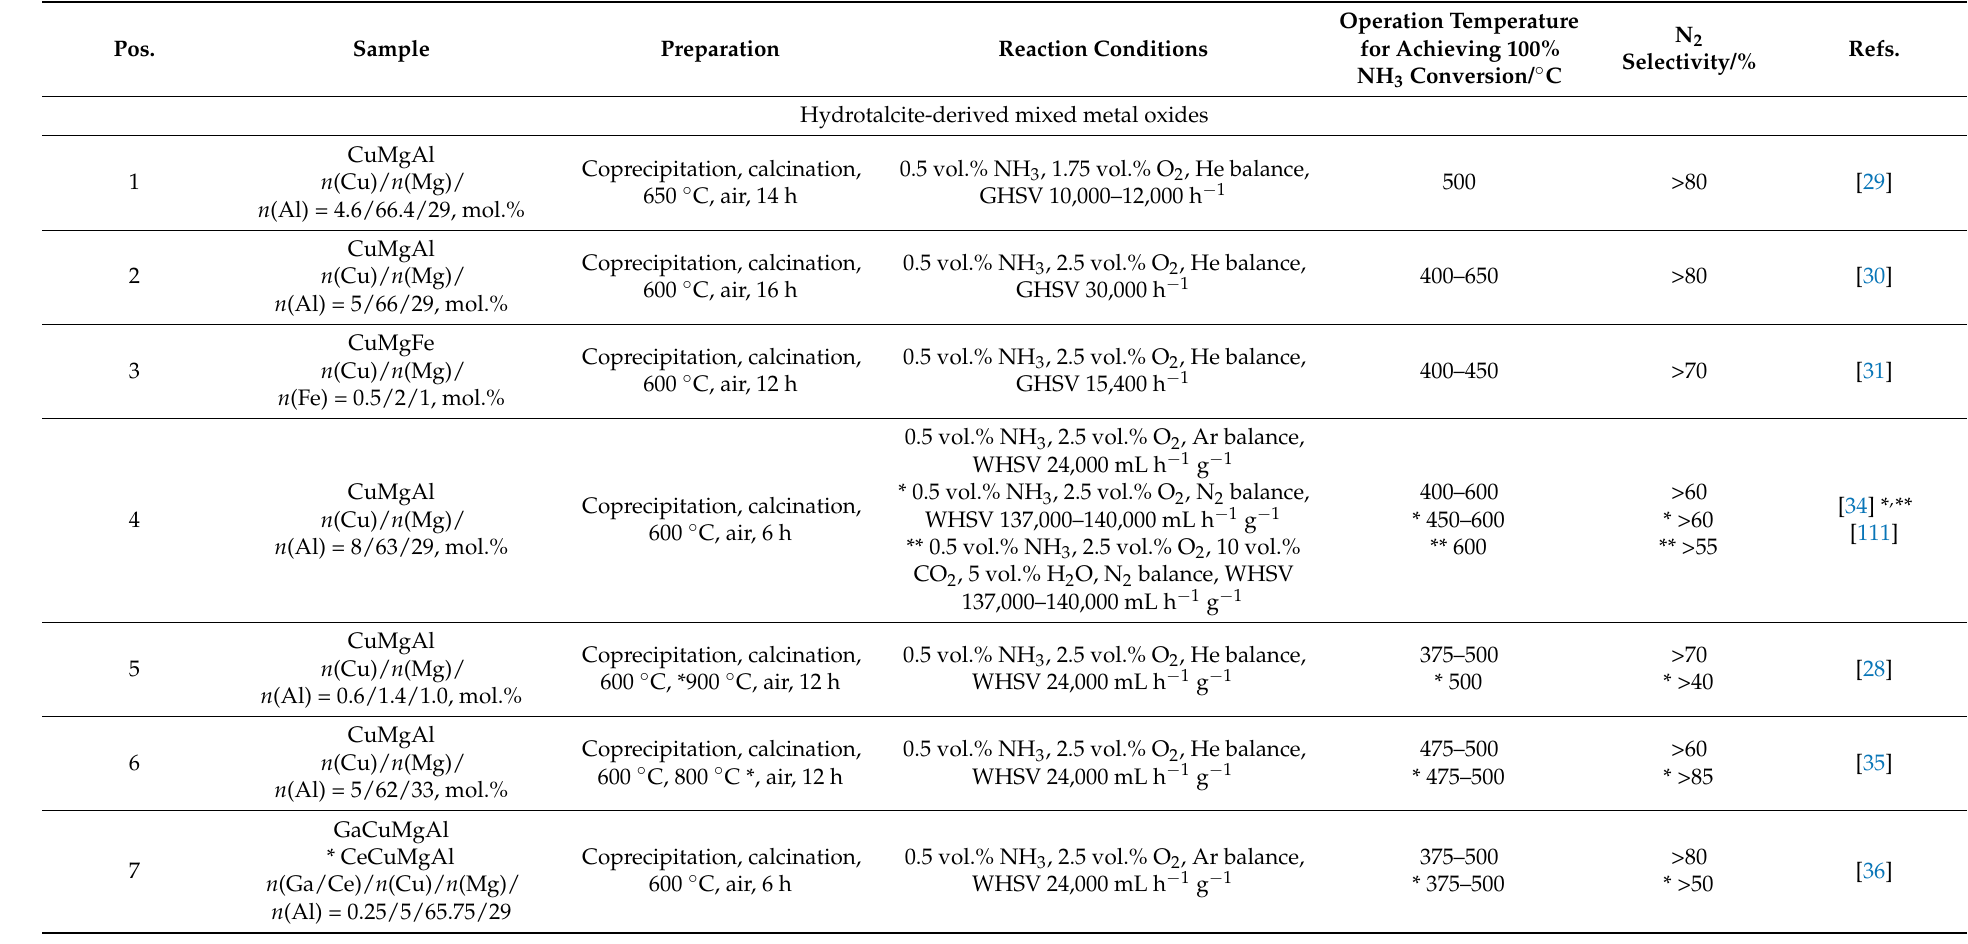
Table 2. Comparison of complete NH 3 conversion and N 2 selectivity in the same temperature range over hydrotalcite-derived mixed metal oxides and other transition metal-based catalysts reported in the literature (related data are marked with